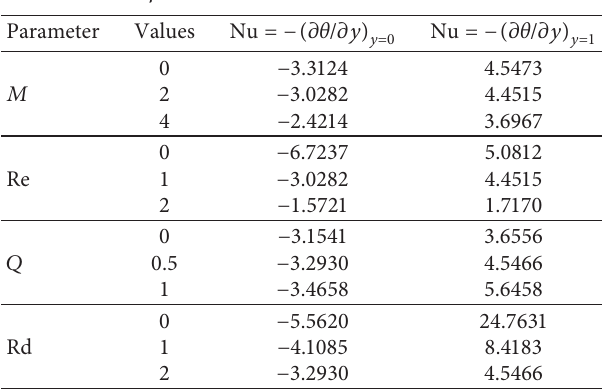
2: The Nusselt number